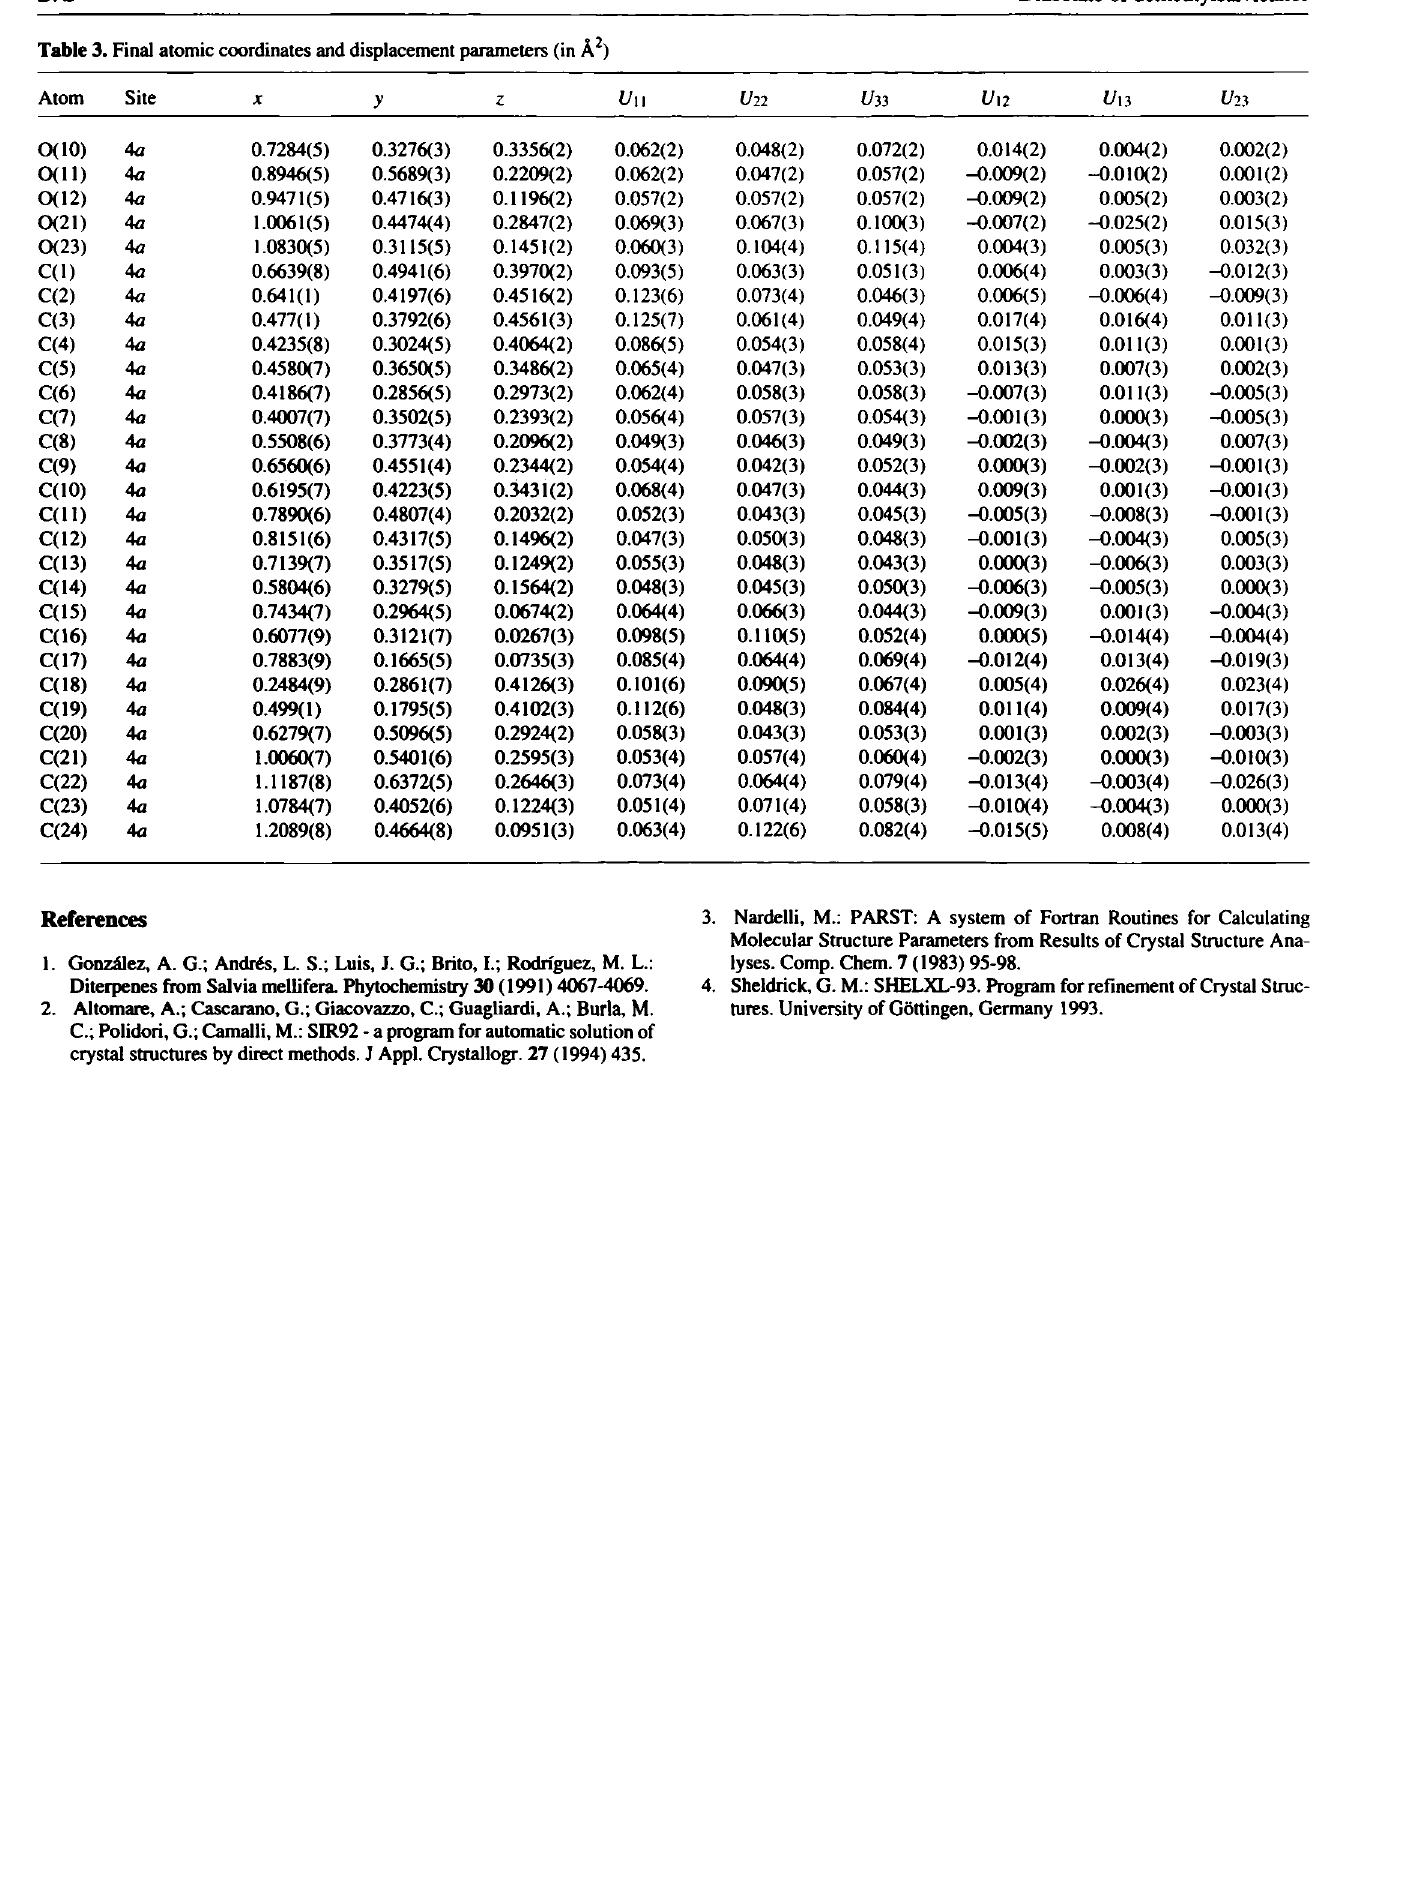
Table 3. Final atomic coordinates and displacement parameters (in